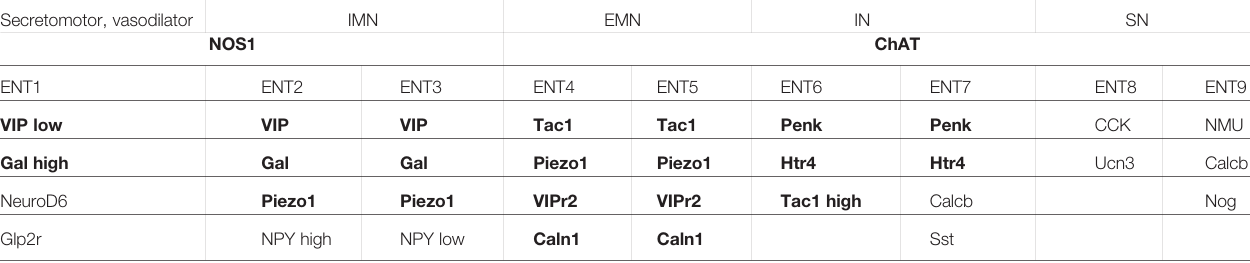
Bold genes represent key transcripts. IMN, inhibitory motor neurons; EMN, excitatory motor neurons; IN, Interneurons; SN, sensory neurons. VIP, vasoactive intestinal peptide; Tac1, gene encoding Substance P; PENK, gene encoding proenkephalin (Opioid); Gal, galanin (neuroendocrine peptide); Piezo1, piezo type